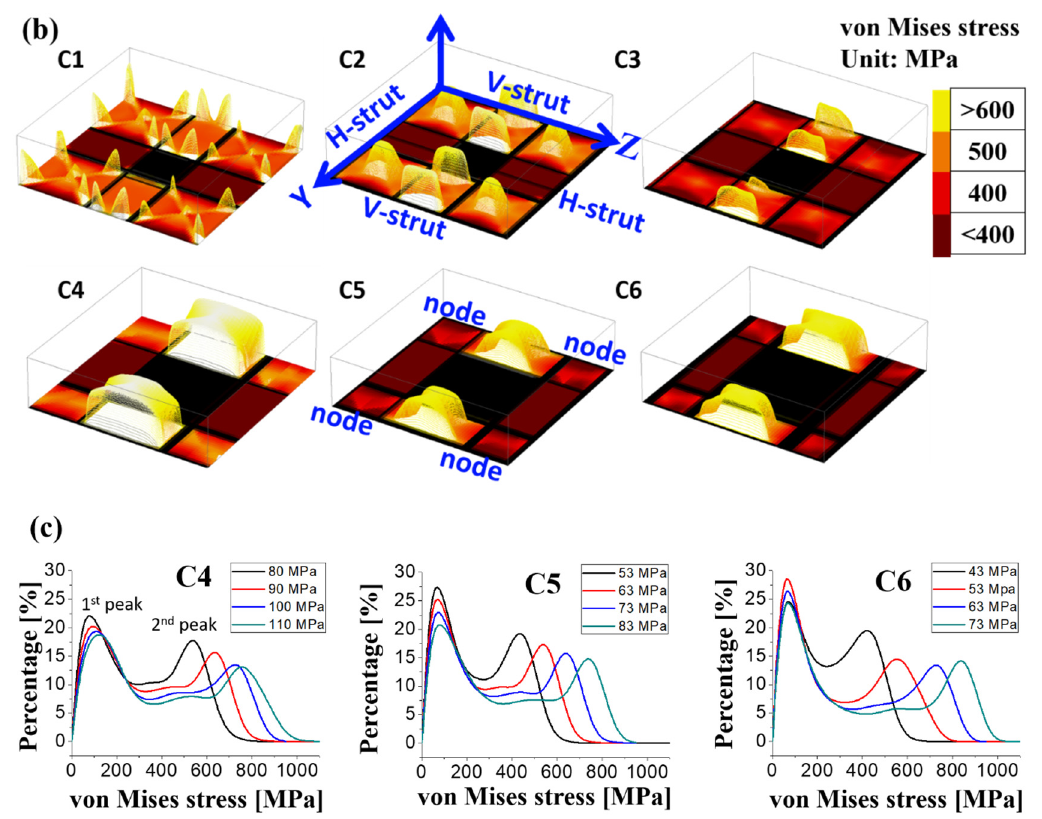
Figure 6. Von Mises stress analysis of the specimens with different porosities using COMSOL software. Side view of the stress distribution for ( a ) whole specimens and ( b ) cells; most stress was concentrated on the vertical struts in all the specimens. X-shaped stress concentration regions were found in C1 and C2 specimens. Stress concentration moved to the center of the struts in C4–C6 specimens. C3 specimen demonstrated a porosity transition. ( c ) Statistical histogram of stress values for the C4–C6 specimens derived from the FEA results. First peak and second peak respectively denote the top surface and strut of the compressive specimen. Applied stress was set on the basis of the yield strength from the experimental values with an increase of 10 MPa for each level.